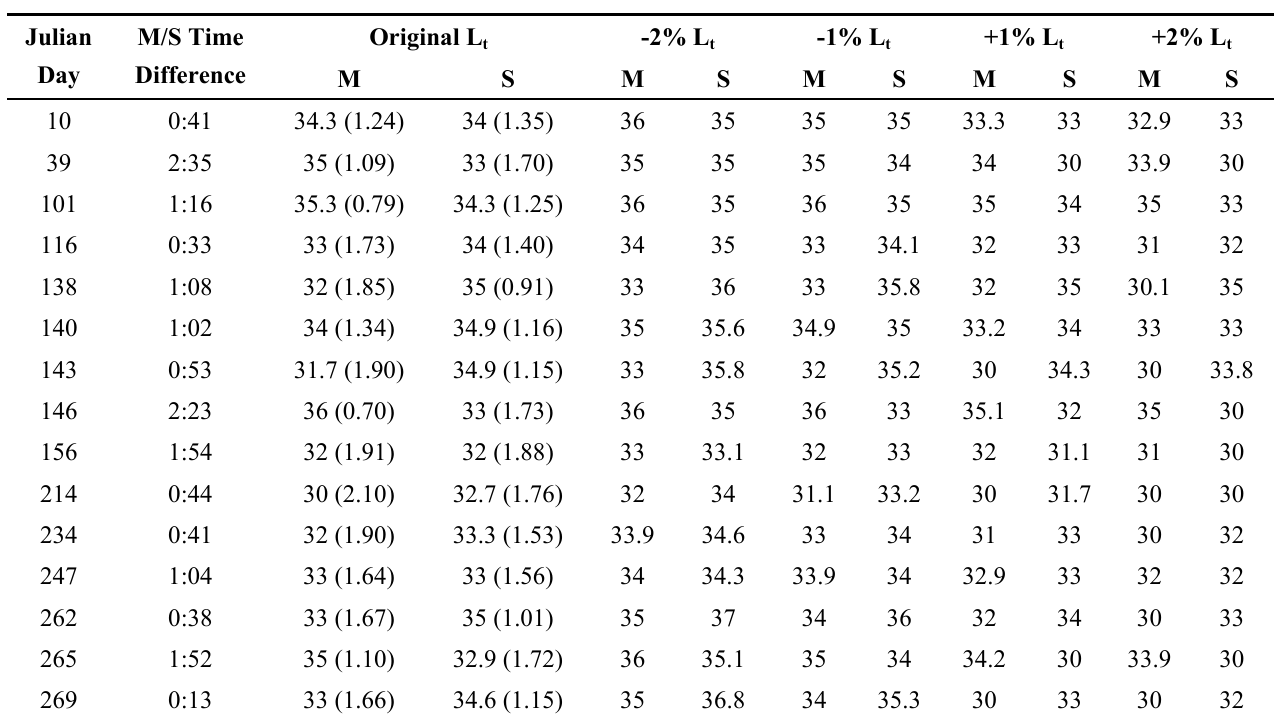
Table 3. MODIS and Sea-viewing Wide Field-of-view Sensor (SeaWiFS) observation time difference and modmin (5 × 5 box means centered on the AERONET-OC site, Venice (748) and L (748) decreased and increased by 1 or 2%. “M” represents 2010), for original L t t MODIS, “S” SeaWiFS. Values in parenthesis under Original L α (443)